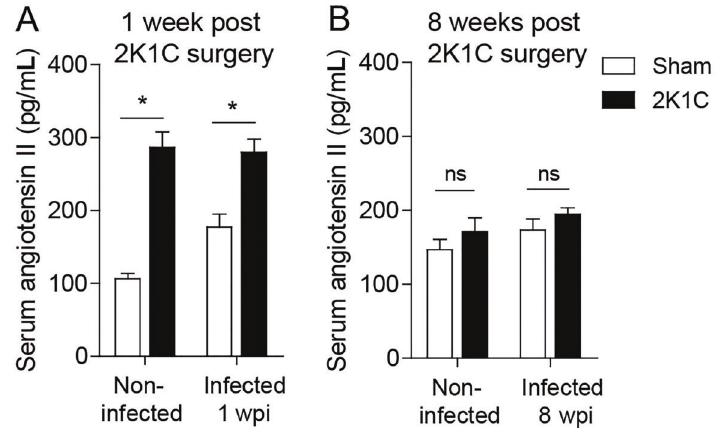
Figure 2. Serum AngII in two-kidney one-clip (2K1C) infected rats. Serum angiotensin II was measured in Wistar rats by immunoassay at 1 ( A ) and 8 ( B ) weeks after the 2K1C renovascular (n=8) and Sham (n=8) surgeries, immediately followed or not by infection with 1.2 (cid:1) 10 6 trypo- mastigote forms of Y strain of the T. cruzi . wpi: weeks post-infection. Data are reported as means ± SE. *P o 0.05, one-way ANOVA fol- lowed by Bonferroni post-test. ns: non-signi fi cant difference. wpi: weeks